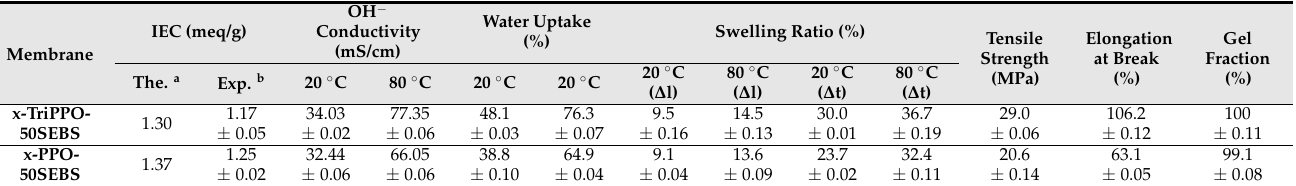
Table 1. IEC, OH − conductivity, water uptake (WU), swelling ratio (SR), mechanical properties, and gel fraction of the crosslinked PPO–SEBS membranes.